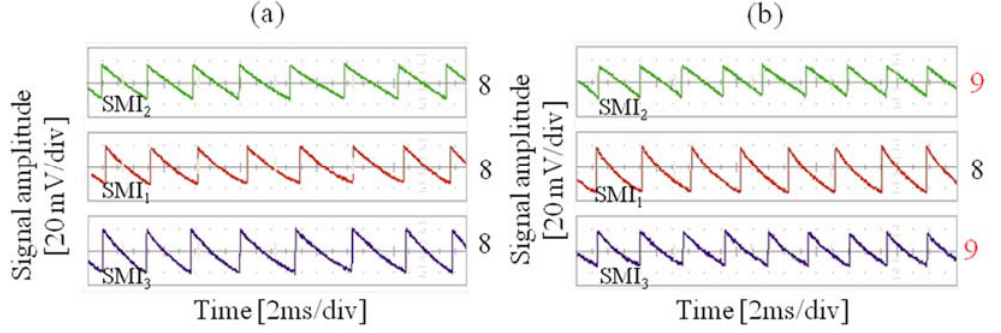
Figure 5. Representative oscilloscope LSM waveforms of the interferometers SMI (i = 1,2,3), obtained at a distance laser-target of 20 cm for (a) pure translational motion, and (b) translation with both yaw and pitch rotations. The number N of interference fringes is reported to the right of each